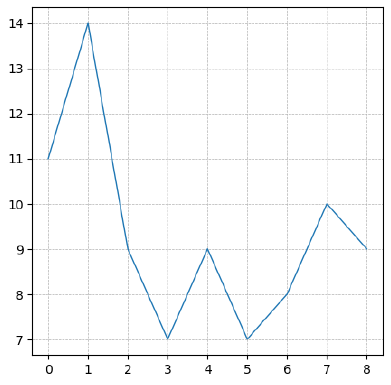
Figure 2. Random profile.